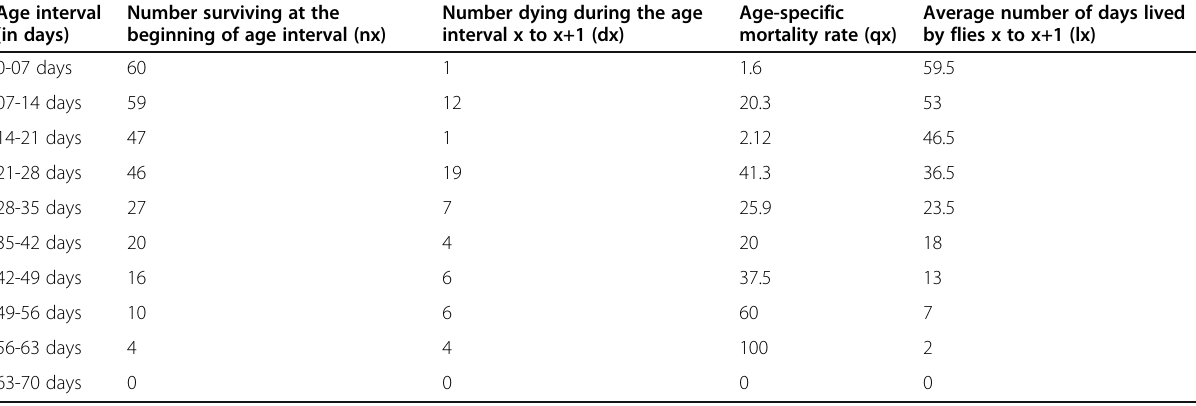
Table 4 Life table depicting survival of D. melanogaster in medium with tulsi extract Age interval Number surviving at the (in days) beginning of age interval (nx)